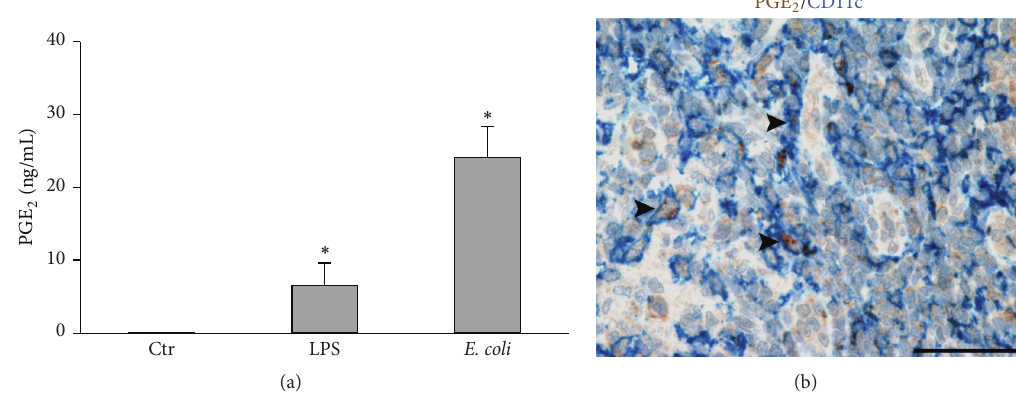
Figure 5: CD11c + cells produce PGE 2 in human inflamed lymph nodes. (a) Circulating mDCs were stimulated with LPS (100ng/mL) or heat-killed E. coli (1: 10mDC/bacteria ratio). After 24 h, supernatants were collected and the production of PGE 2 was evaluated by EIA. Data are expressed as mean ± SEM ( 𝑛 = 3 ); ∗ 𝑃 < 0.05 by one-way ANOVA with Dunnett’s post hoc test. (b) Sections from FFPE reactive lymph nodes were stained as indicated. Cytoplasmic PGE 2 is observed in a fraction of CD11c + cells. Representative double positive cells are indicated by arrow heads. Sections are counterstained with Meyer’s haematoxylin. Original magnifications: 400x (scale bar 50 𝜇